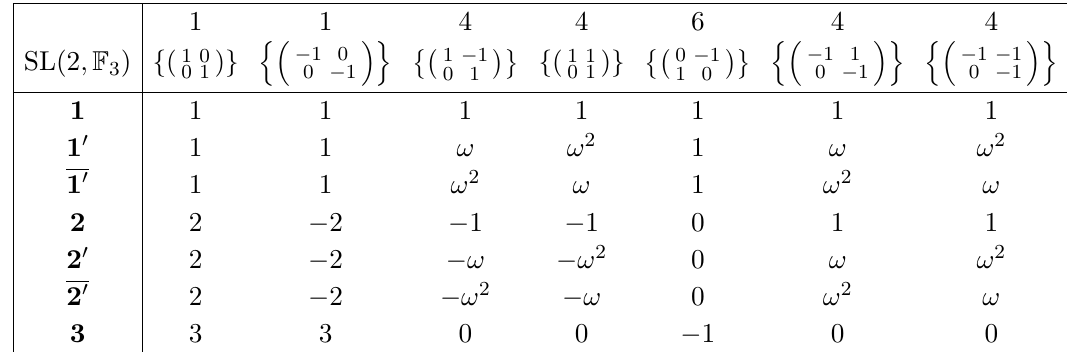
Table 4. Character table for the group SL(2 , F 3 ) . The columns are labelled by representatives of conjugacy classes, with the numbers of elements in each class written